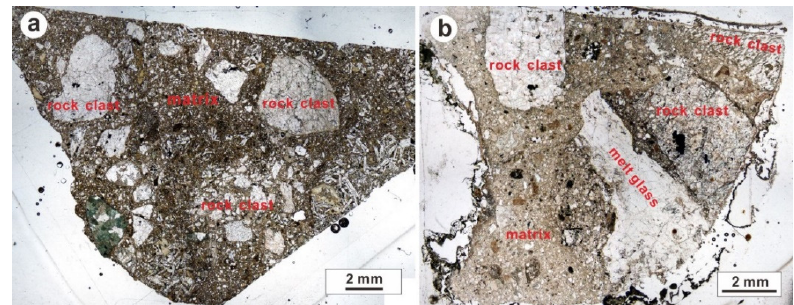
Figure 1. Mosaic images of thin sections of the lithic breccia ( a ) and suevite ( b ) (plane polarized light, PPL).